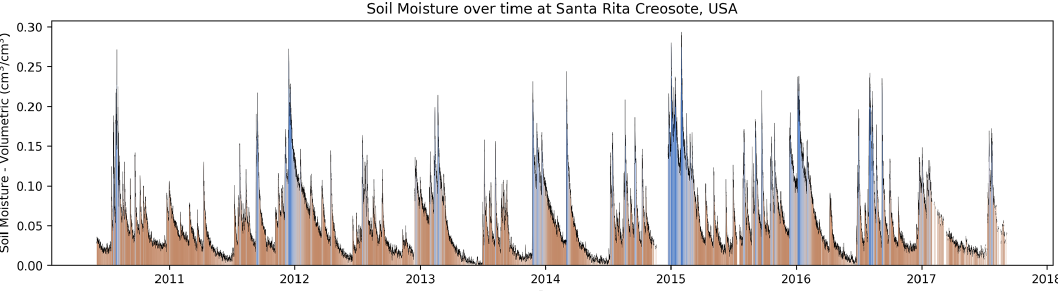
Figure B1. Charts that take the fully corrected SM data and plot them over the entire time series are output automatically. Optional yearly plots are also possible. The colouring is used to visually see the difference between wet (dark blue) and dry (dark brown) periods (code is found in “graphical_functions.py” under the “colourts()” function).